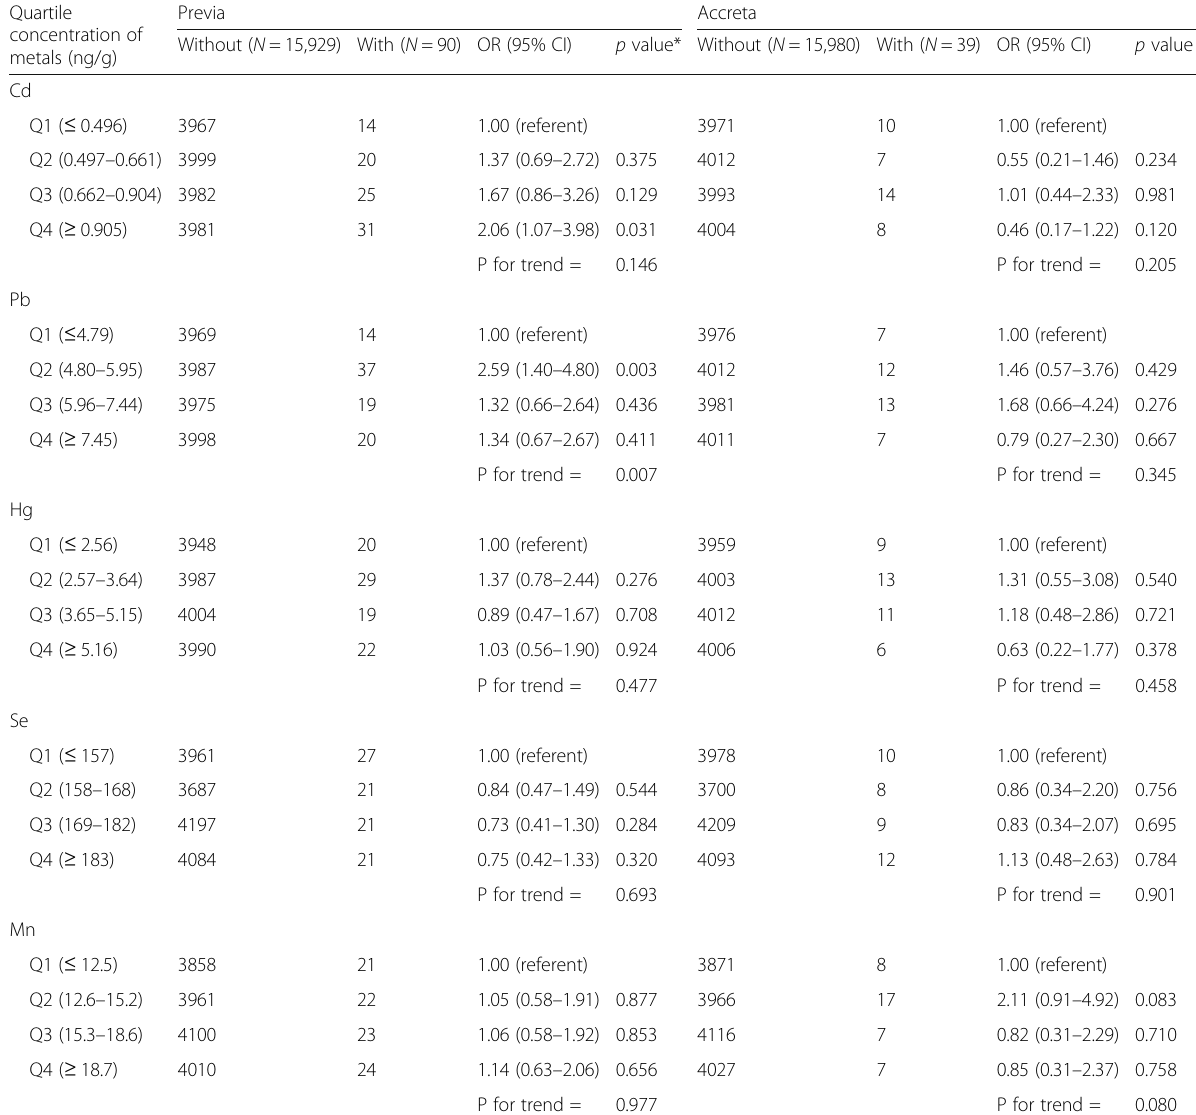
Table 3 Results of multivariable analysis regarding the relationship between quartile concentrations of metals, placenta previa, and placenta accreta Quartile concentration of metals (ng/g)